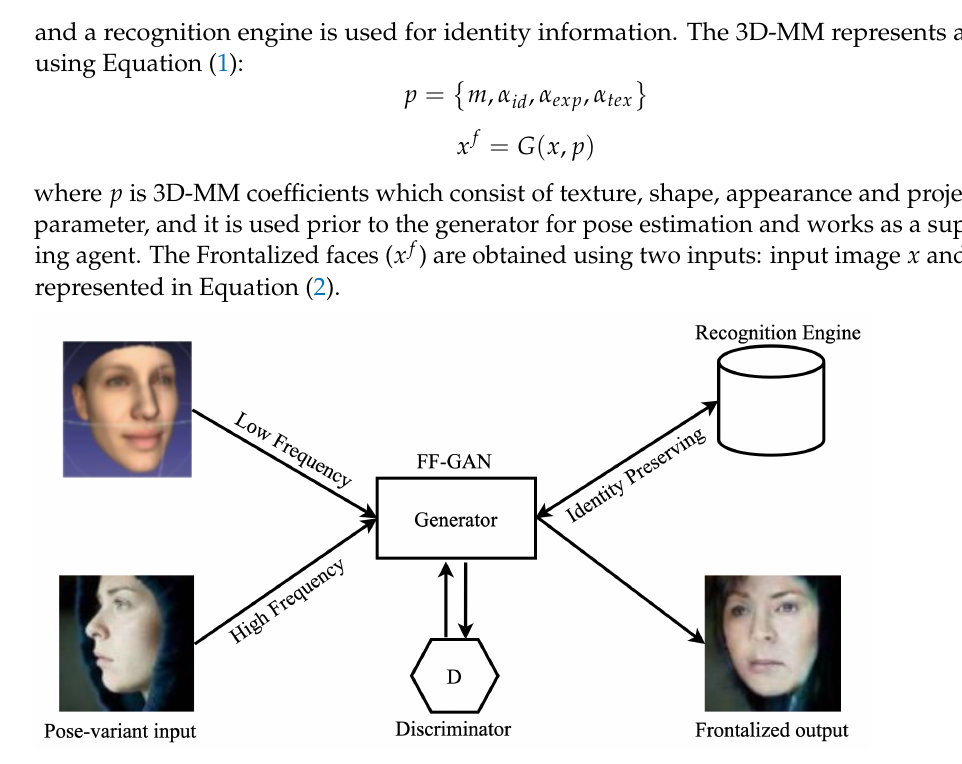
Figure 6. General framework of the FF-GAN method